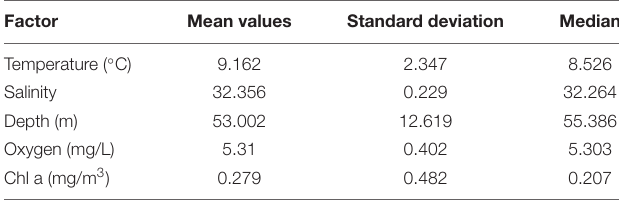
TABLE 3 | Results of correlation analysis between environmental variables and abundance of Calanus sinicus at YSCWM station (3500-09) at night.